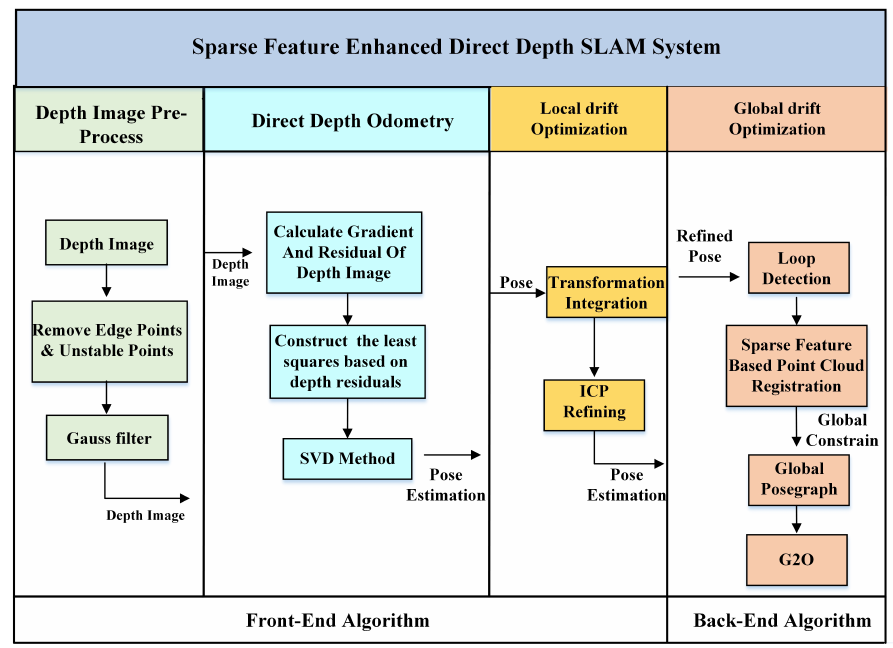
Figure 3. The pipeline of the proposed Depth SLAM